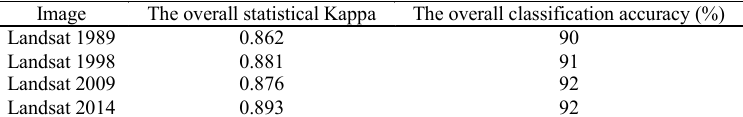
Table 3: Results of Classification accuracy assessment